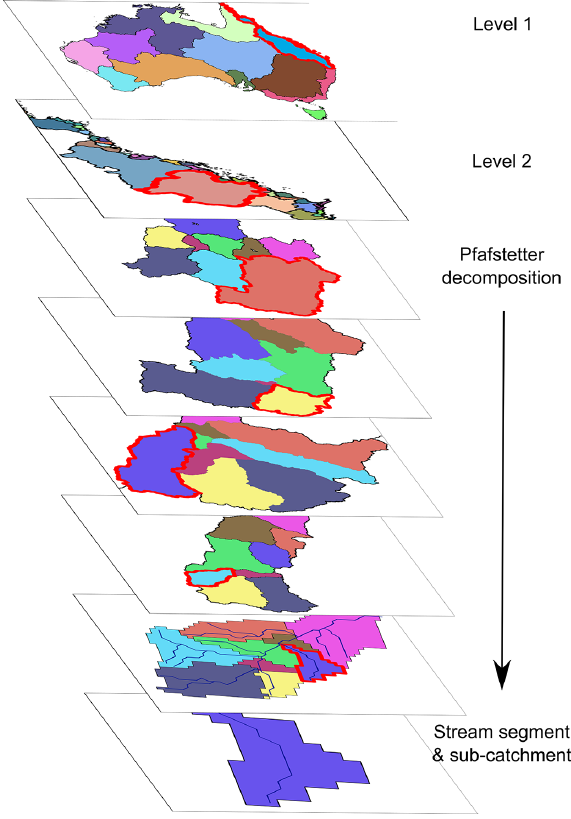
Figure 2. Components of the nested stream and catchment database. The nested hierarchy of catchments aggregates drainage basins at its highest levels and at its lower levels, sub-divides basins into succes- sively smaller catchment units based on the Pfafstetter system. The smallest units in the catchment framework are the catchment ar- eas draining to individual stream segments in the associated DEM stream network. Attributes describing the natural and anthropogenic environment of the stream and its catchment are contained in the re- lated lookup tables. The area shown at each level is highlighted with a red boundary at the next higher